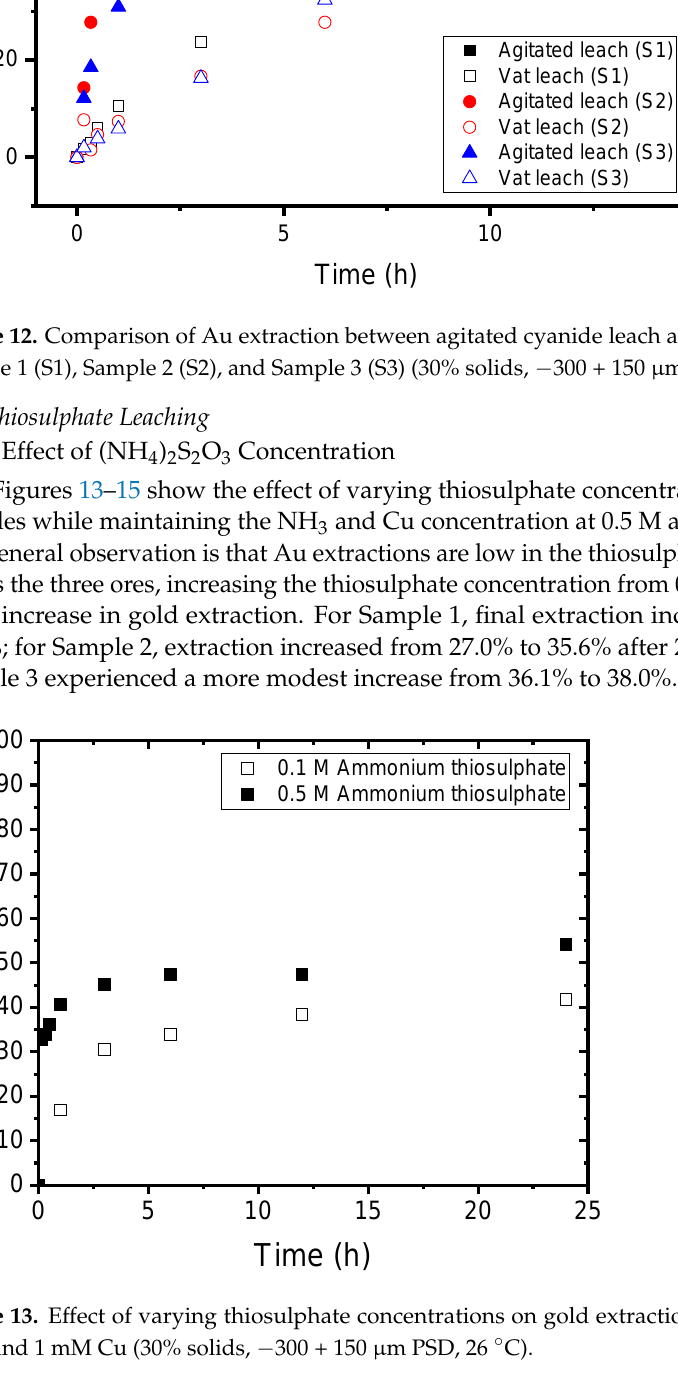
Time (h) Figure 14. Effect of varying thiosulphate concentrations on gold extraction for Sample 2 at 0.5 M NH 3 and 1 mM Cu (30% solids, −300 + 150 µm PSD, 26 °C).